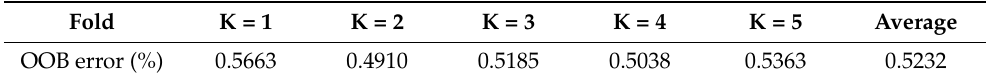
Table 6. K-fold Validation results of random forest (RF) model.